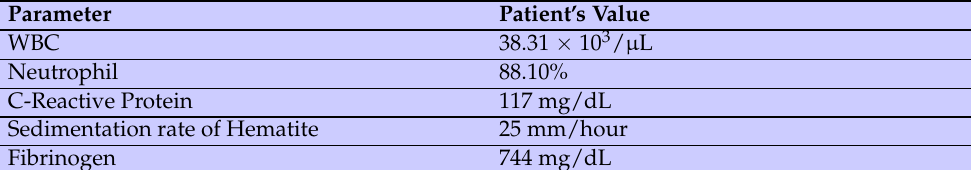
X-ray cord-lung: interstitial drawing of reticular micronodular type, intensely accentu- Pulmonary hilum with enlarged projection area. Cord, aorta in normal limit (Figure